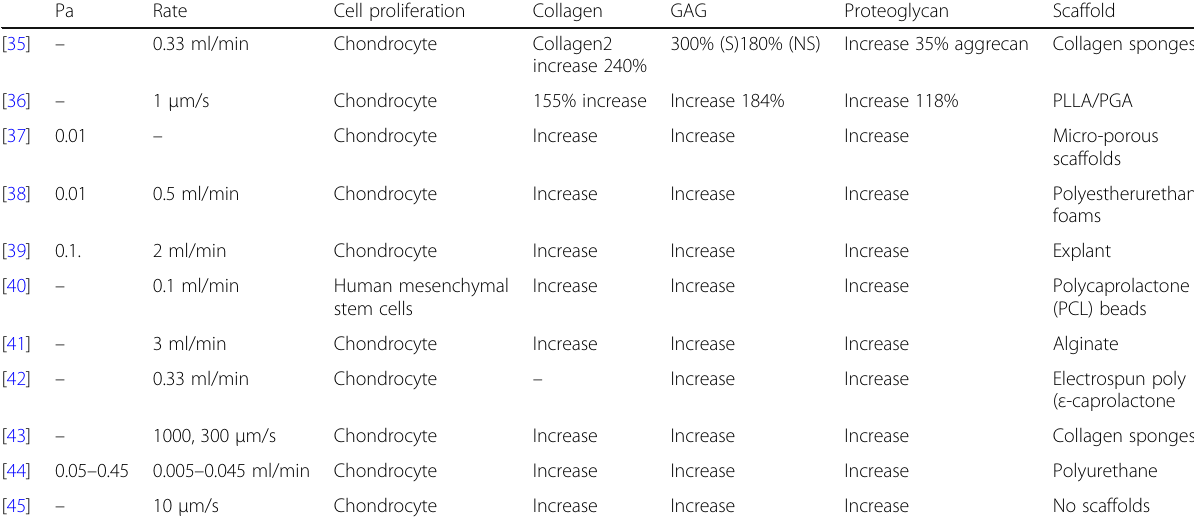
Table 7 Effect of perfusion bioreactor on chondrocyte proliferation and matrix composition Pa